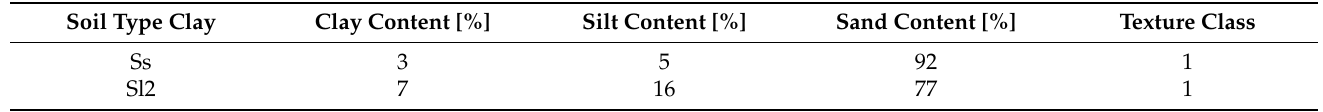
Table 19. Matrix for determining the texture class from sand and clay contents (authors’ adaptation after